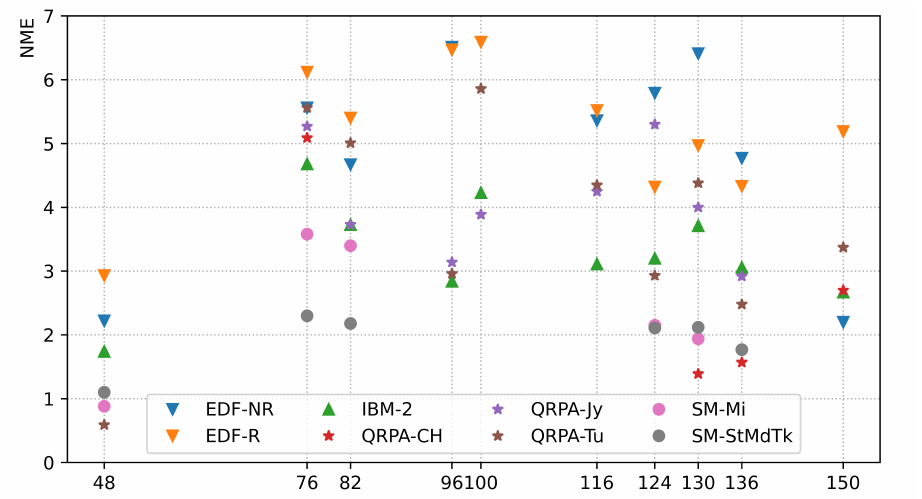
Figure 2. Comparison of NME calculations with an unquenched g A = 1.27 for different isotopes and with various models. Abbreviations: EDF, energy-density functional; IBM, interacting boson model; NME, nuclear matrix element; QRPA, quasi-particle random-phase approximation; SM, Standard Model. The reader should refer to [25] for further